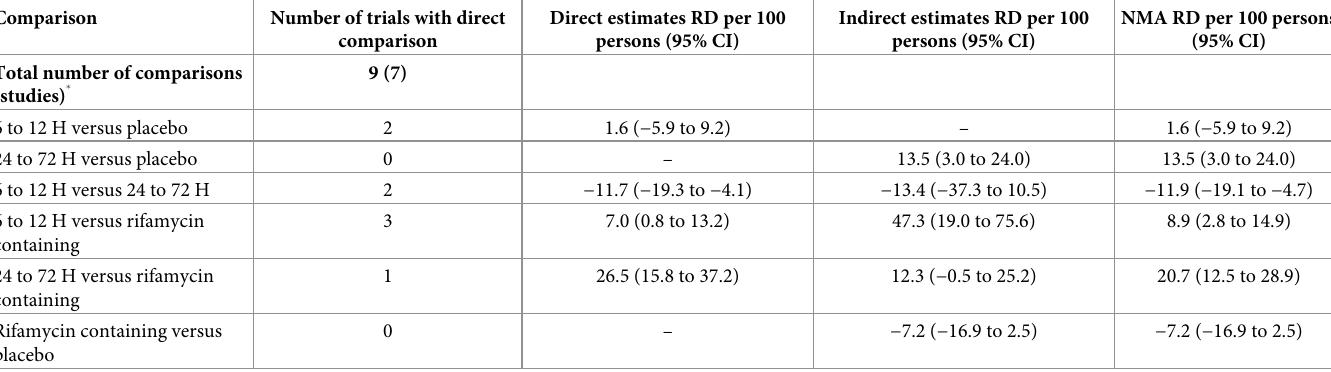
Table 5. NMA of RD of grade 3 or worse hepatotoxicity during treatment, by aggregated TPT